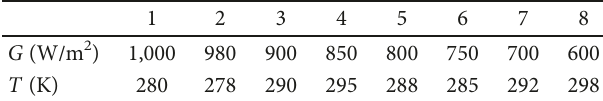
Figure 13: Model of a hybrid energy conversion system in MATLAB/Simulink. Table 4: Values of temperature and solar irradiation used for the PV system.